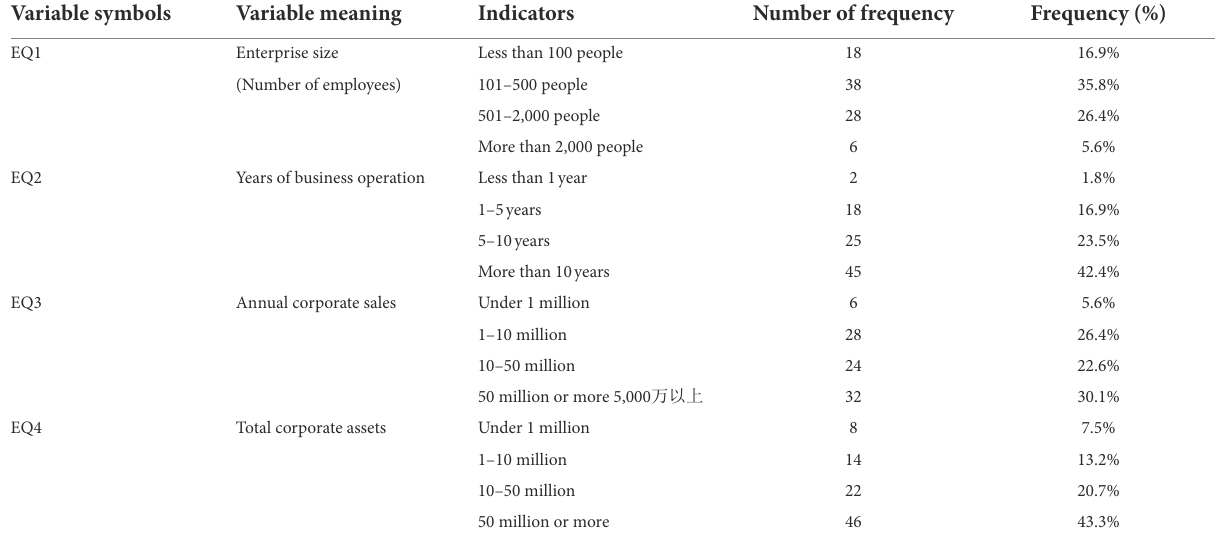
TABLE 1 Structure of the sample distribution ( N = 90). Variable